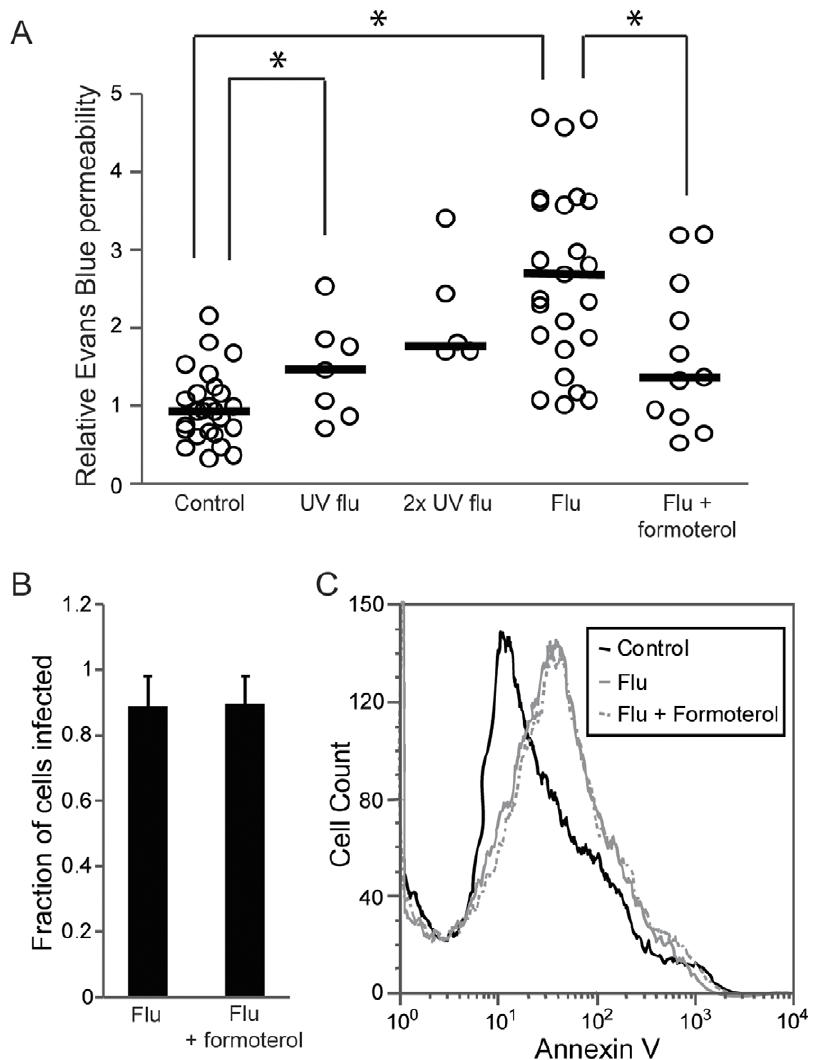
Figure 10. Human influenza causes lung vascular leak in a murine model, which is abrogated by formoterol. (A) C57BL/6 mice were infected nasally with UV influenza (128 HAU/mouse and 256 HAU/mouse), and live human influenza (128 HAU/mouse). Some mice infected with live influenza were given formoterol (0.2 mg/kg) or vehicle by intraperitoneal injection immediately afterwards and daily for 3 days. Lung vascular leak was measured by injection of Evans Blue (EB). Results are means normalized to serum EB levels (to control for unequal administration) and to the mean control EB of the experiment, *p , 0.05. (B) Replication of influenza (MOI 8) in mouse lung endothelial cells (with or without 0.1 m M formoterol) was assessed by immunofluorescence for viral nucleoprotein as in Figure 1. Data are mean and SE from 3 experiments. (C) The reduction in lung permeability from formoterol is not due to decreased endothelial apoptosis. Mouse endothelial cells infected with live influenza (MOI 8) with or without formoterol (0.1 m M) were probed with Annexin V 24 hours later. Histogram is representative of 3